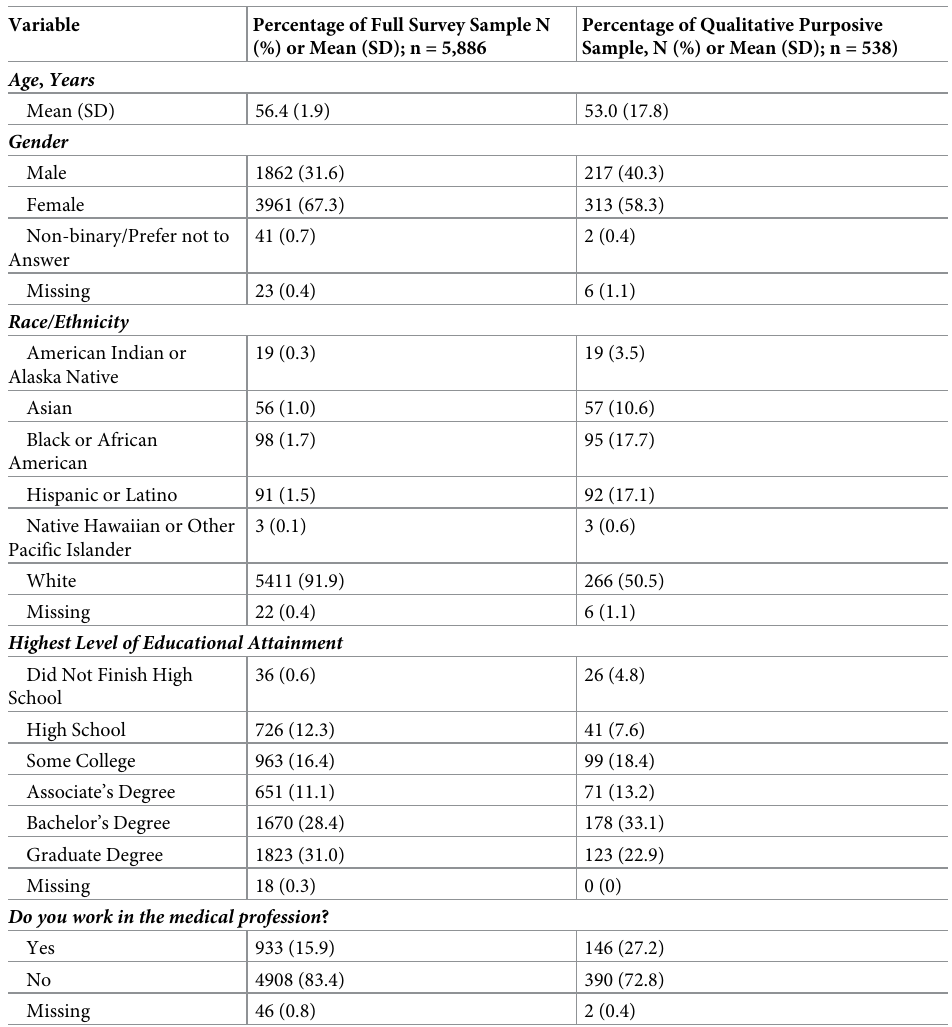
Table 1. Participant demographics.